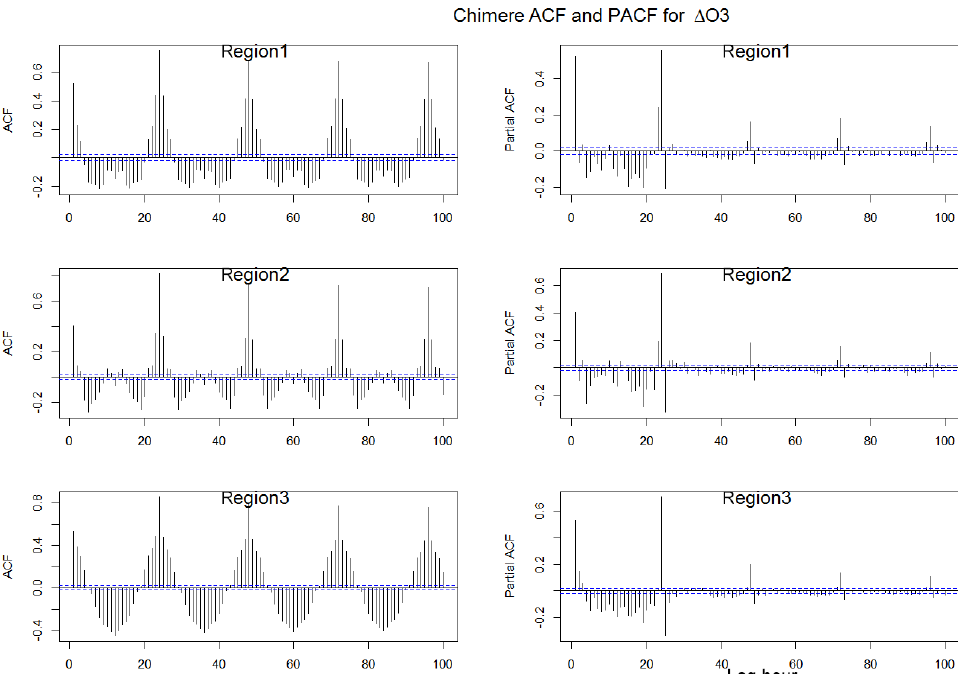
Figure 22. Chimere model: autocorrelation (ACF) and partial autocorrelation (PACF) functions for the differenced time series of residuals of ozone (model–observations). The differentiation is necessary to remove non-stationarity and thus to convey the ACF and PACF values depending on lag only.